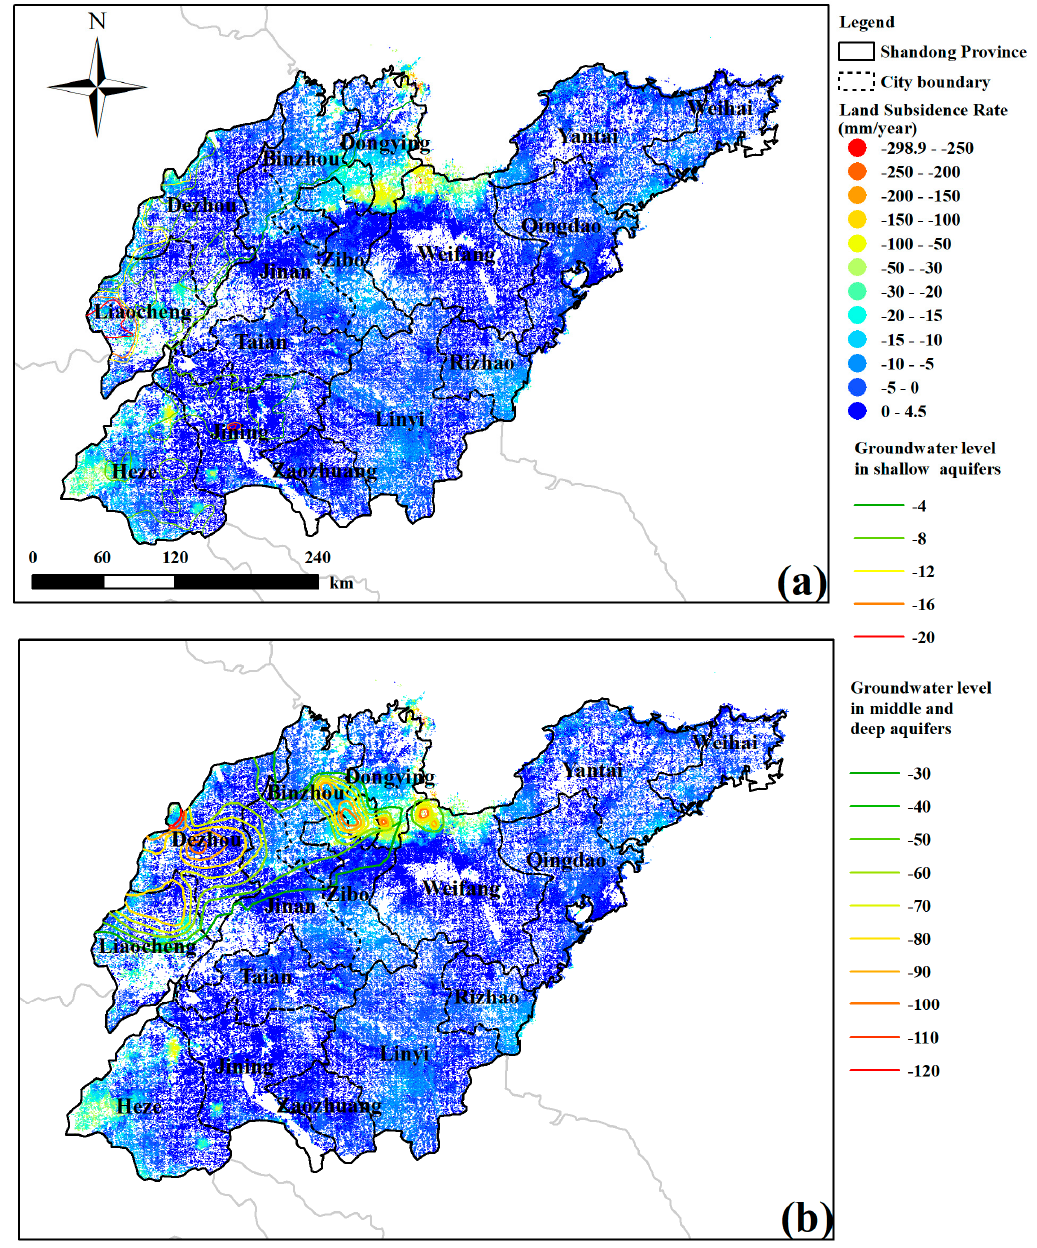
Figure 9. ( a ) Spatial response relationship between the groundwater level in shallow aquifers and mean land subsidence rate. ( b ) Spatial response relationship between the groundwater level in middle and deep aquifers and mean land subsidence rate.